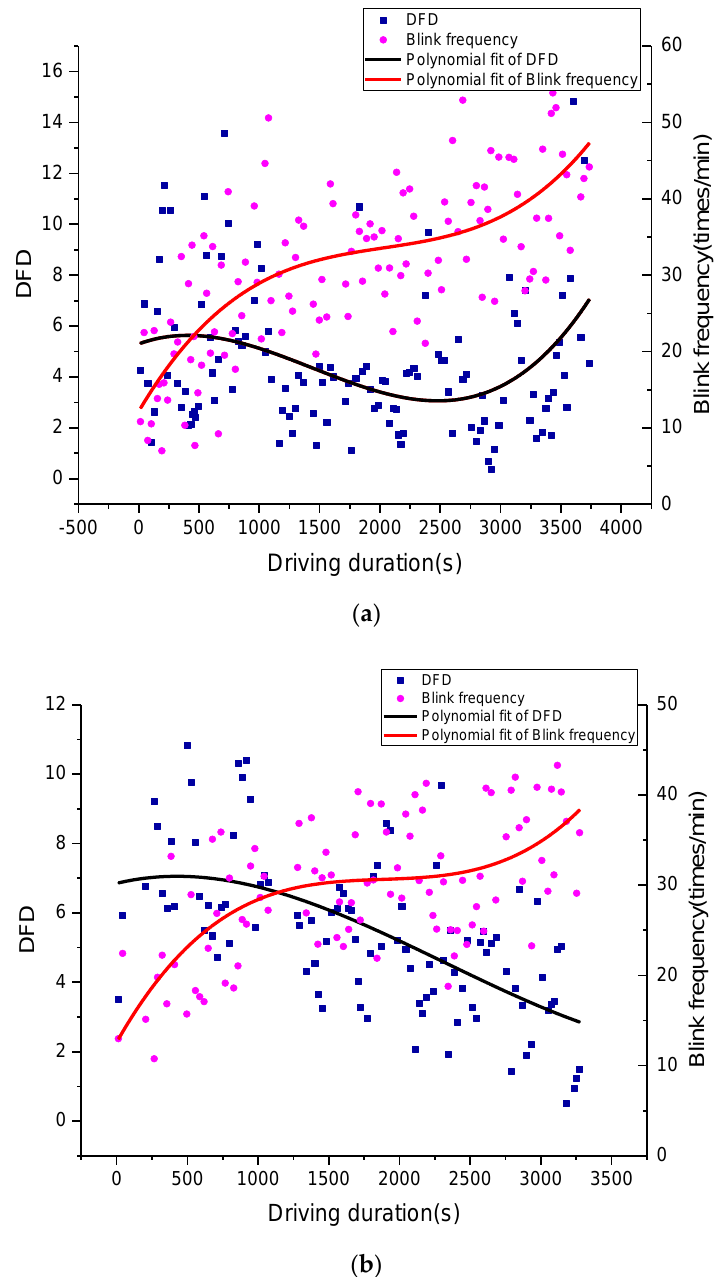
Figure 8. Variations in DFDs with altitude and driving duration of segment 1: ( a ) upslope road segment and ( b ) downslope road segment.